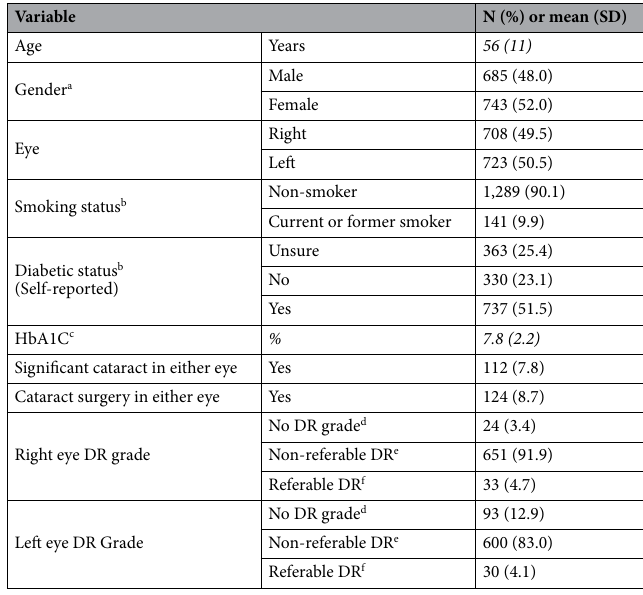
Table 1. Study dataset patient demographics and characteristics. SD Standard deviation, DR Diabetic retinopathy. a 3 missing gender values. b 1 missing value for smoking and diabetic status respectively. c 23 missing HbA1C values. d Patient eyes with ungradable images only hence there is no DR grade. e Includes no DR, mild DR and stable treated proliferative DR. f Includes moderate non-proliferative DR, severe non- proliferative DR and proliferative